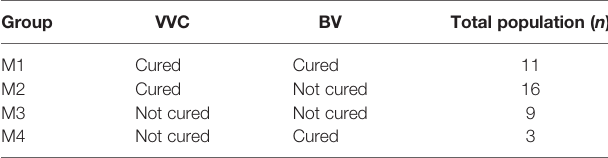
TABLE 1 | Grouping information of the study population without